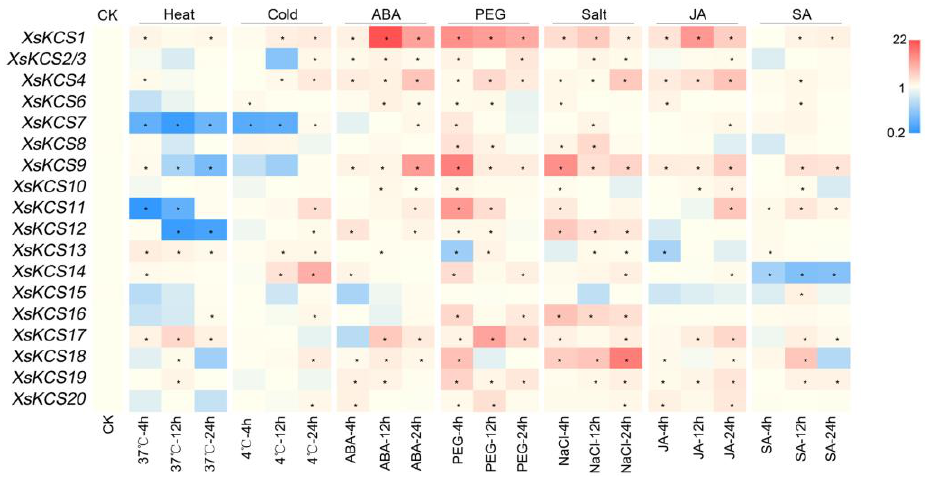
Figure 7. The expression heat map of XsKCS genes under different stress treatments. Scale bar on the right represents the relative expression level of each gene detecting by qRT-PCR. * indicates significant differences at p < 0.05. The significance analysis was performed by SPSS 25 with one-way ANOVA and Duncan multiple comparison